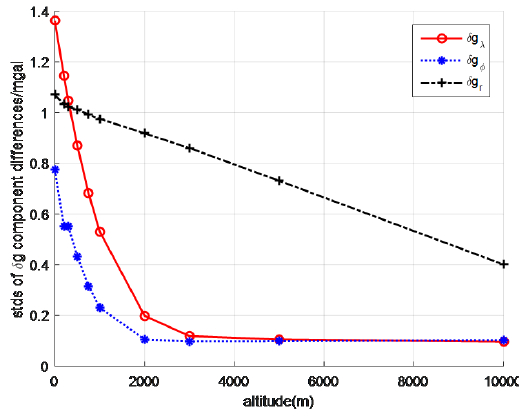
Fig. 6. difference of δg r between classical Stokes integral values and true values at altitude 500